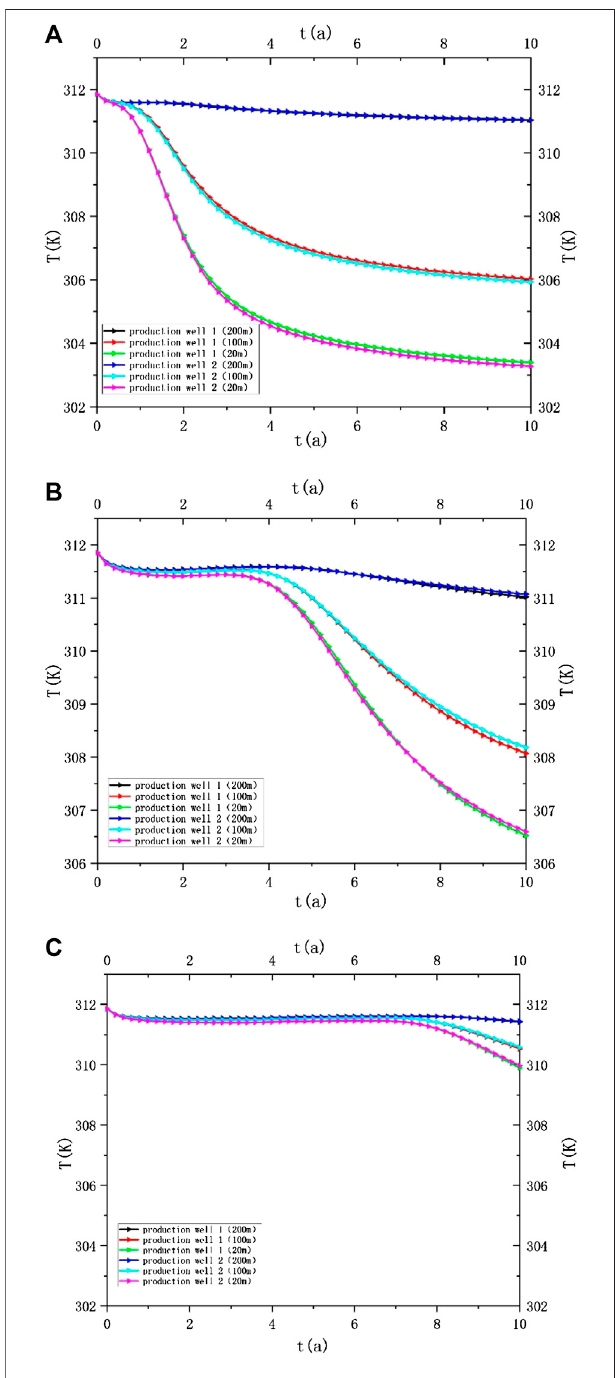
FIGURE 7 | Temperature changes of production wells 1 and 2 under different spacings between production wells. (A) Temperature changes of production well 1 and 2 at a distance of 100 m between production and reinjection wells. (B) Temperature changes of production well 1 and 2 at a distance of 300 m between production and reinjection wells. (C) Temperature changes of production well 1 and 2 at a distance of 500 m between production and reinjection